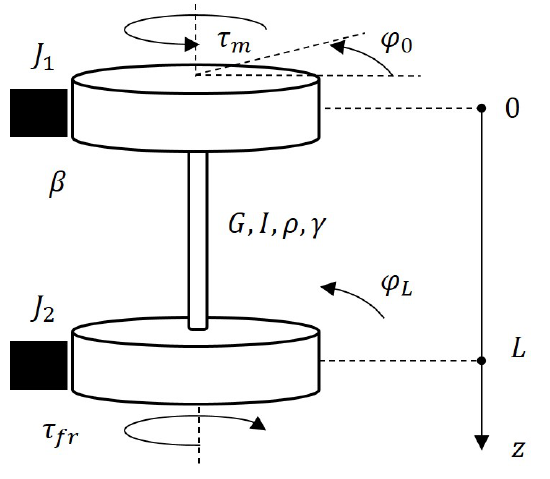
Figure 1. Electromechanical